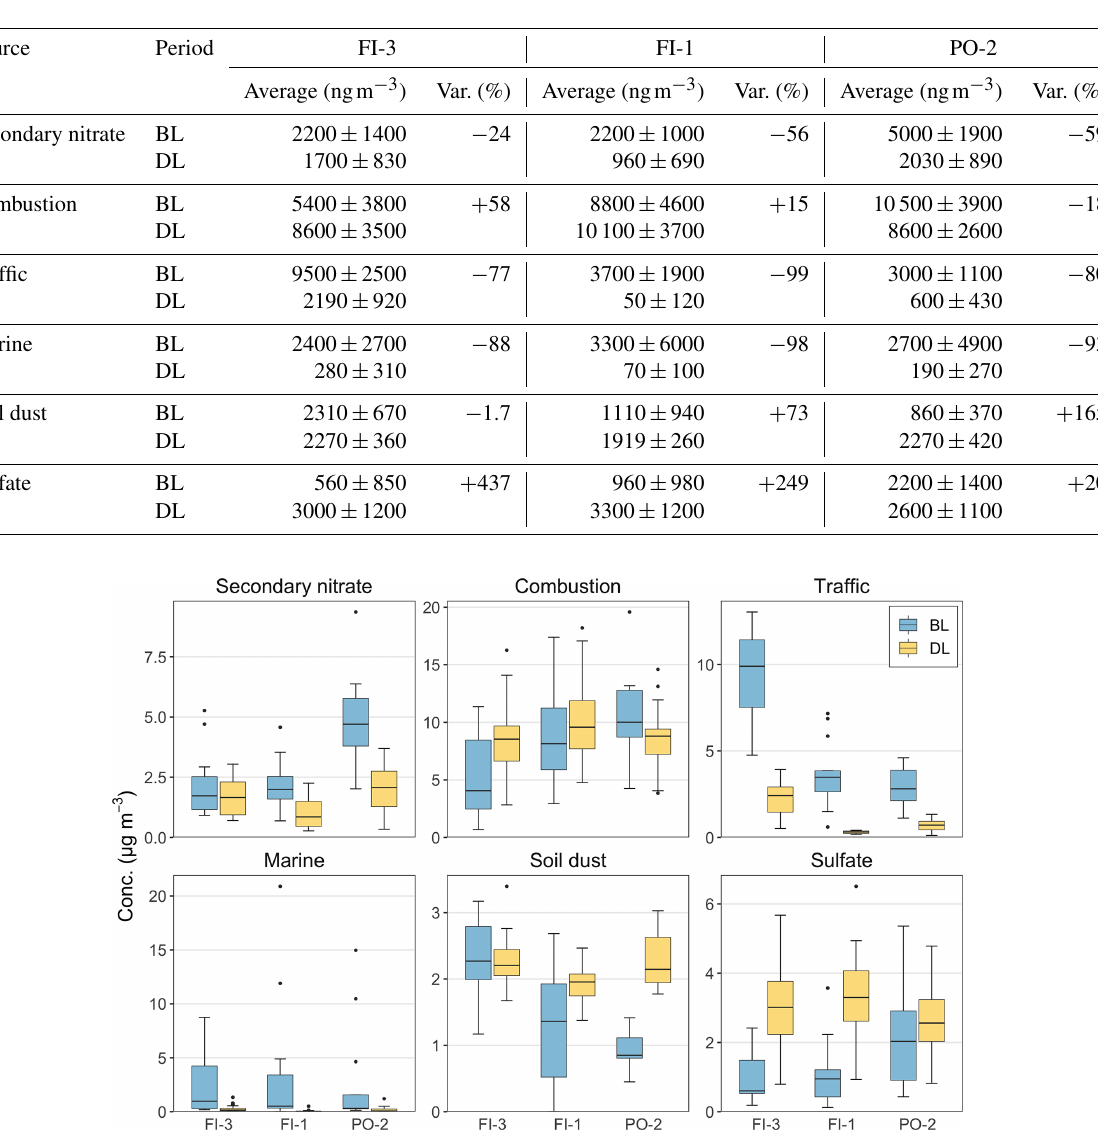
Table 6. Average concentrations ( ± standard deviation) of the six sources for the three sampling sites as well as their relative variation between the period before the lockdown (BL) and during the lockdown (DL).